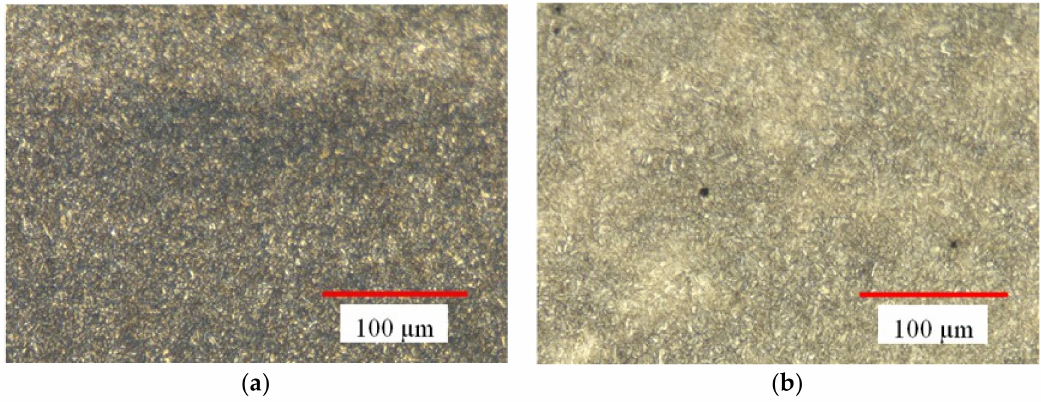
Figure 3. Microstructure of the quenched and tempered 34CrNiMo6 high strength steel ( a ) Longitudinal section; ( b ) Transversal